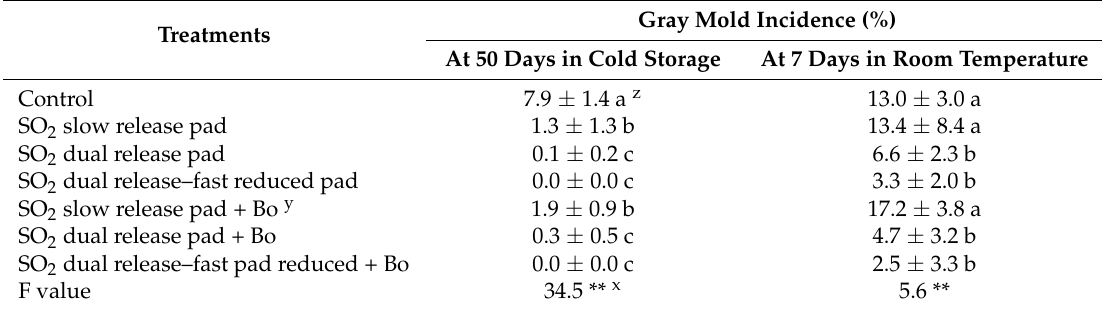
Table 1. Gray Mold Incidence (%) of ‘BRS Vitoria’ seedless table grapes at 50 days of cold storage and 7 days of room temperature under different SO 2 pad